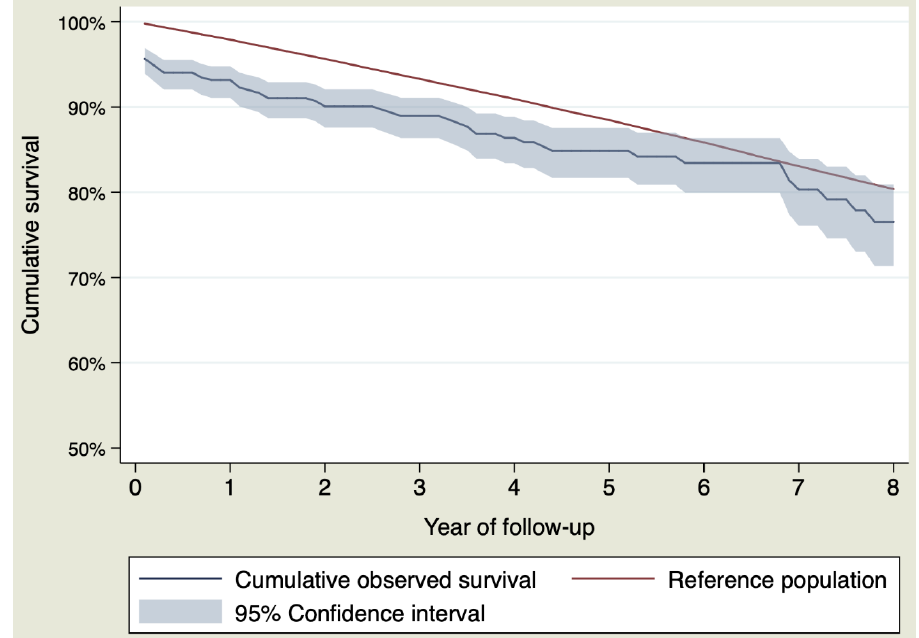
Figure 1. Observed and expected survival for the whole sample.